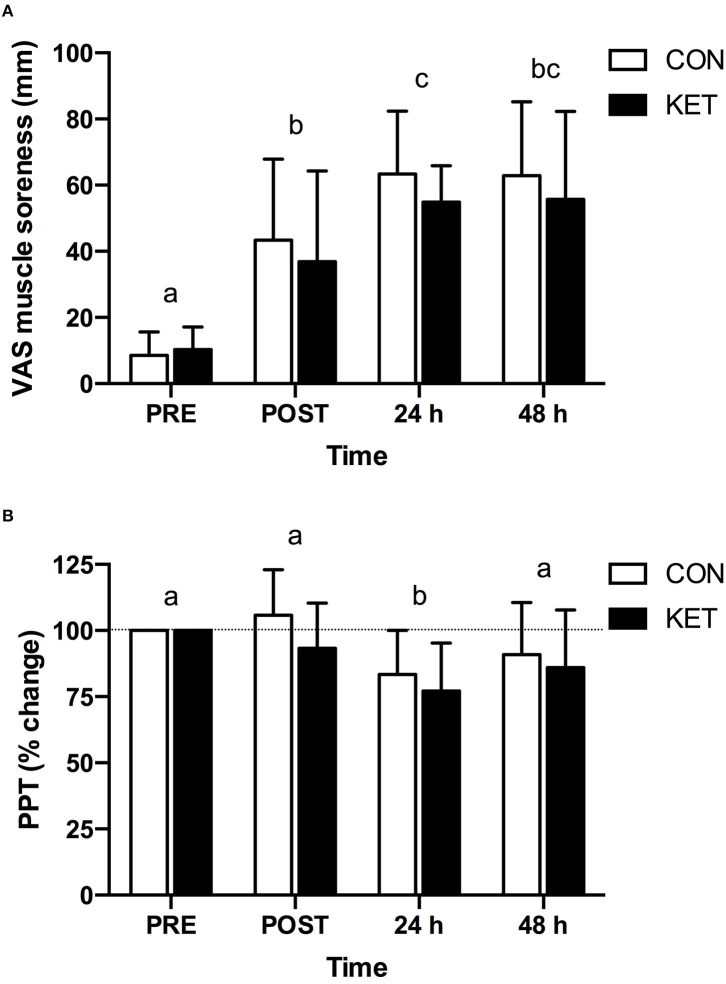
Visual analog scale derived muscle soreness (A) and percent change in pressure-pain threshold (B) at or relative to baseline (PRE) prior to exercise, and immediately (POST), 24 h and 48 h after exercise. Values represent means ± SD. Times without a common letter differ. Data were analyzed with a two-factor repeated measures (within subject factor: time; between-subject factor: group) ANOVA. Bonferroni-corrected post-hoc comparisons were performed following a significant main effect for time or group × time interaction. Visual analog scale derived muscle soreness; time effect: P < 0.001; group effect: P = 0.896; group × time interaction: P = 0.517. Pressure-pain threshold; time effect: P < 0.001; group effect: P = 0.113; group × time interaction: P = 0.492. CON, carbohydrate control group; KET, ketone monoester group; PPT, pressure-pain threshold; VAS, visual analog scale.